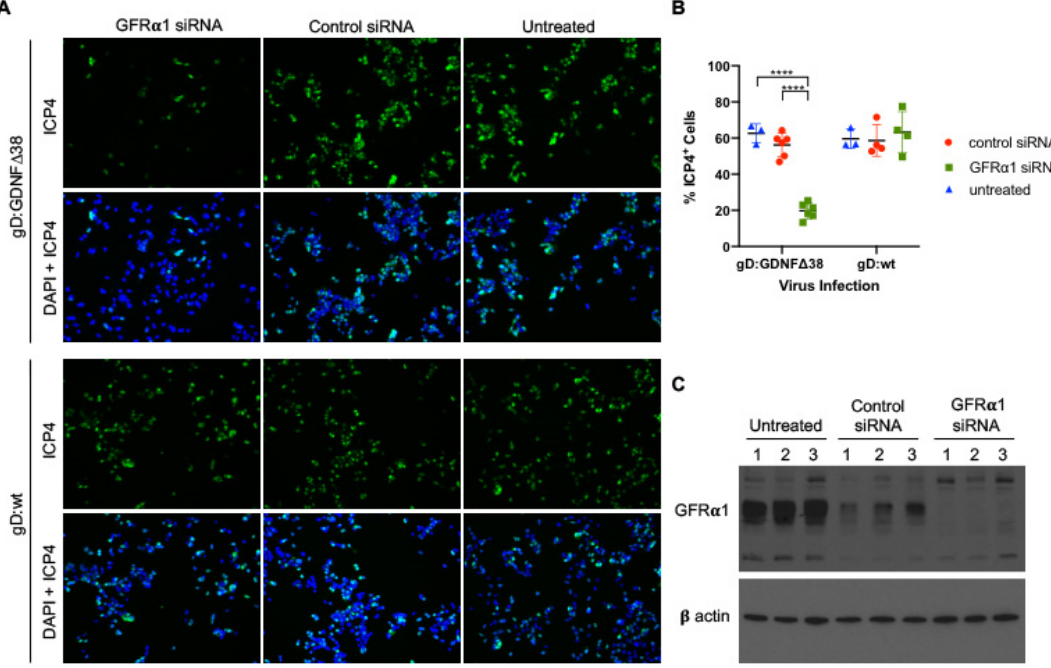
Figure 5. Virus infection of GFR α 1 siRNA transduced cells. ( A ) MCF7 cells transfected with GFR α 1-specific or non-specific (“Control”) siRNA pools were infected after 72 h with KNTc-gD:GDNF ∆ 38 (2 pfu / cell) or KNTc-gD:wt (0.2 pfu / cell) and stained at 6 hpi for ICP4 (upper rows) and DAPI (DAPI + ICP4, lower rows); representative images from triplicate infections are shown. ( B ) Quantification of the ICP4 + cell populations as a percentage of the total analyzed cells (DAPI) was performed for each treatment group using ImageJ software. Averages represent counts from 3–6 images ± SD; statistical di ff erences were determined by two-way ANOVA (**** p < 0.0001). ( C ) Untreated and siRNA-treated MCF7 cells were assessed for GFR α 1 protein expression by Western blot analysis of whole cell lysates; three biological replicates are shown for each condition. β -actin detection was used as loading control.